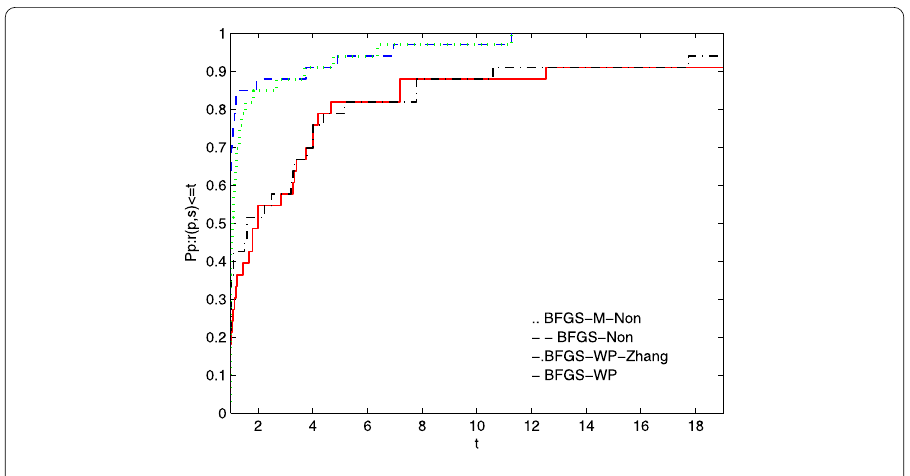
Figure 3 Performance profiles of these methods